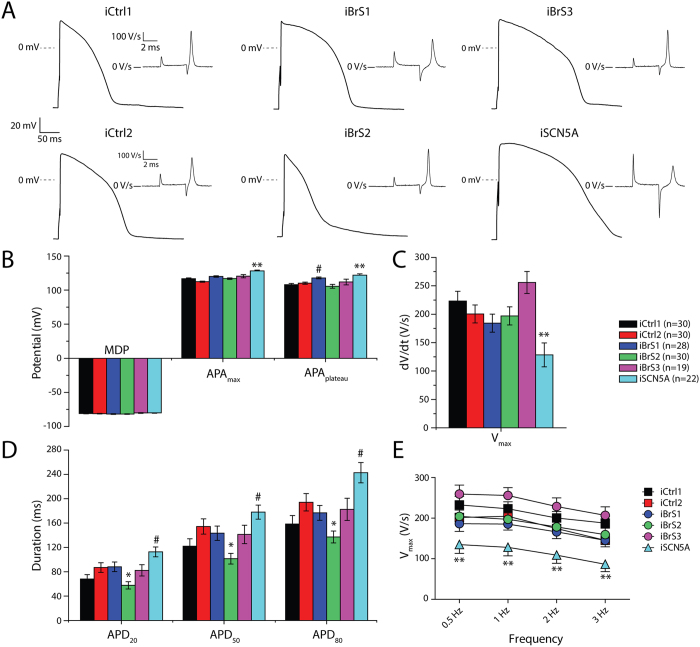
AP characteristics as measured after addition of in silico IK1 in hiPSC-CMs from iCtrl1, iCtrl2, the three BrS patients iBrS1 to iBrS3 and iSCN5A.(A) Typical examples of APs measured at 1 Hz. Inset show the first derivatives displaying AP upstroke velocity. (B) Averages of maximum diastolic potential (MDP), maximum AP amplitude (APAmax) and amplitude of the plateau (APAplateau), measured after 10 ms from the onset of the upstroke. (C) Maximal upstroke velocity (Vmax) at 1 Hz. Vmax in hiPSC-CMs from iBrS1, iBrS2 and iBrS3 is not significantly different from iCtrl1 and iCtrl2, in contrast to iSCN5A, which shows a marked reduction (p < 0.05; ANOVA, followed by Bonferroni posthoc tests). (D) Action potential duration (APD) at 20, 50 and 80% of repolarization (APD20, APD50 and APD80, respectively). APD is reduced in iBrS2 compared to iCtrl2 (p < 0.05), while iSCN5A exhibits an increase in APD compared to iCtrl1 (p < 0.05; ANOVA, followed by Bonferroni posthoc tests). (E) Rate dependency of Vmax at frequencies of 0.5 to 3 Hz. No additional differences are exposed at higher or lower frequencies. **p < 0.05 vs iCtrl1 and iCtrl2. #p < 0.05 vs iCtrl1 *p < 0.05 vs iCtrl2.